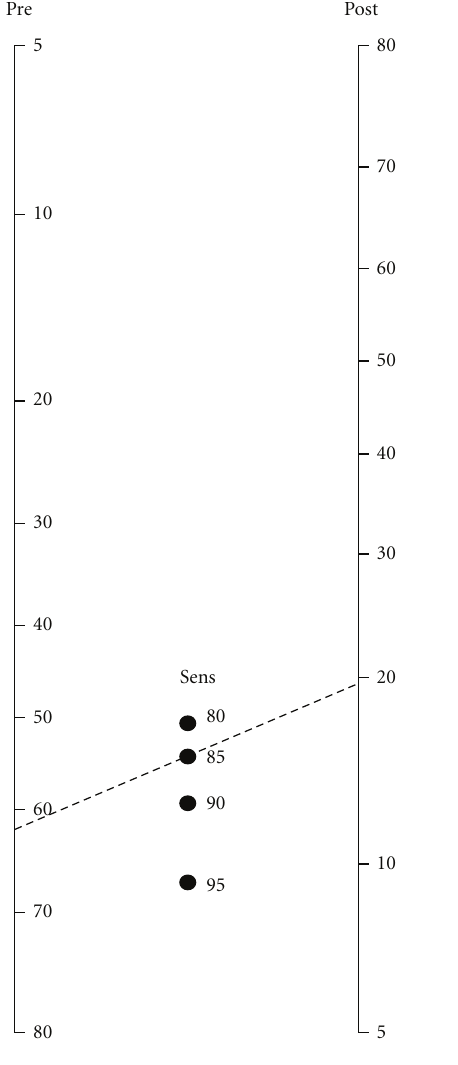
Figure 1: Bayesian nomogram for probability of metastatic disease as a function of pretest probability and negative SLN biopsy. The “pre” or pretest probability of axillary disease can be estimated using a risk calculator such as the one described [14]. The “sens” or sensitivity of SLN biopsy can be estimated using Table 1. Positions for the central dots are calculated assuming a SLN biopsy sensitivity of 80%, 85%, 90%, or 95%; specificity is assumed to be 100%. The calculation for the example patient is shown by the dotted line: if we assume sensitivity of 85% for SLN biopsy and a pretest probability of 62%, the posttest probability for axillary disease is 20% for this patient even in the presence of a negative SLN biopsy.